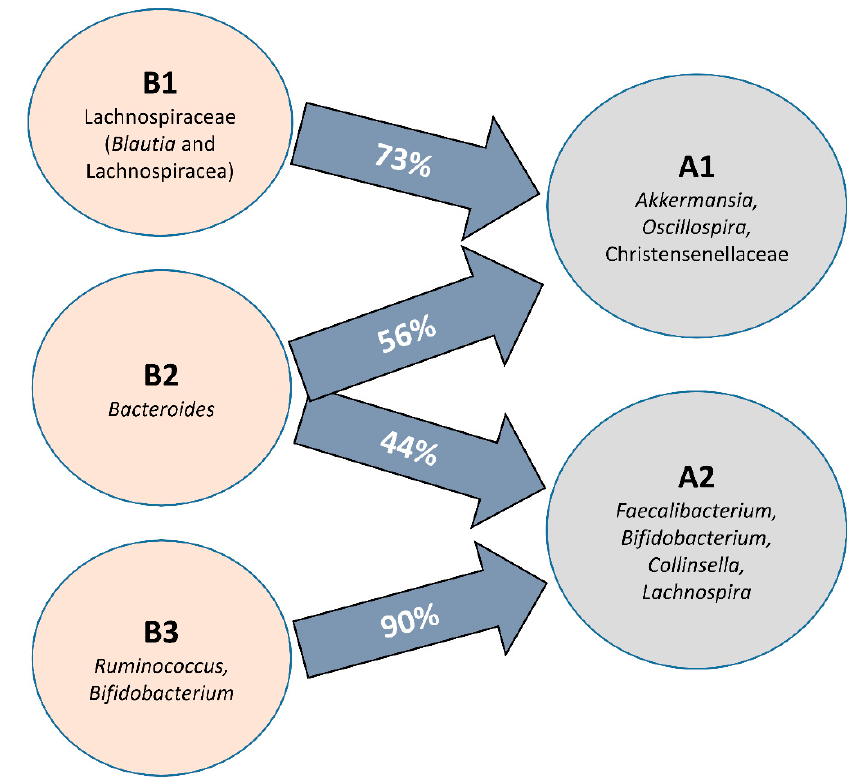
Figure 3. Diagram showing the proportion of participants whose microbiota composition migrates from the baseline groups (B1–3) during the intervention to new microbial profiles after horchata consumption (A1–2) at the genus level.